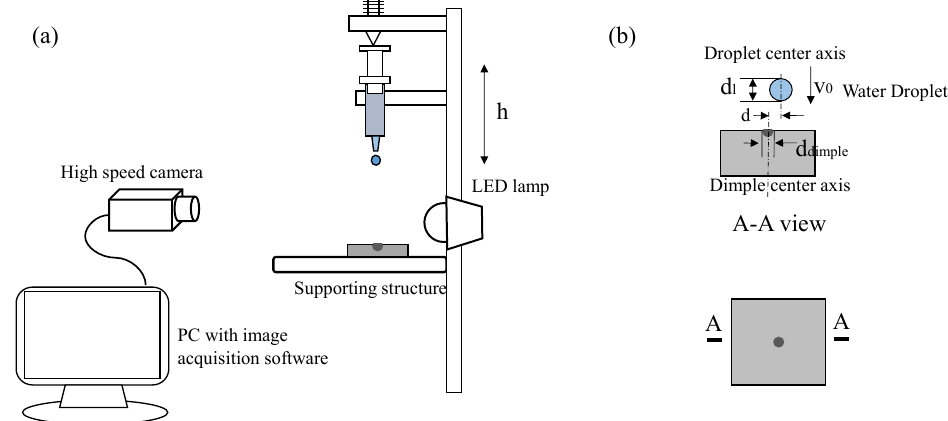
Figure 1. ( a ) Schematic of the experimental setup for droplet impact, ( b ) details of the solid surface. A high-speed camera (Miro M310, Phantom) was used to record the impact process at 4000 frames per second. The camera was placed parallel to the horizontal surface to obtain the side-view images and videos of impacting droplets. An LED lamp with a diffuser was used for illumination. The recorded images and videos were analyzed by the Phantom camera control software obtained from the camera supplier.